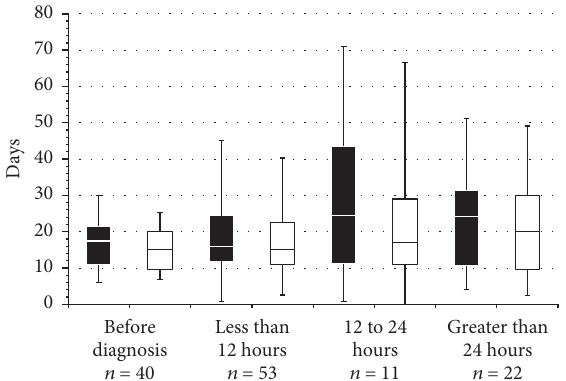
Figure 2: ICU length of stay and duration of mechanical ventilation related to antibiotic initiation time. Box plots of ICU length of stay ( ◼ ) and duration of mechanical ventilation duration ( ◻ ) related to antibiotic initiation time. Box plots show the median value and 25th and 75th percentiles; the whiskers show the mean ± 1 standard deviation. Numerical differences were not statistically significant.